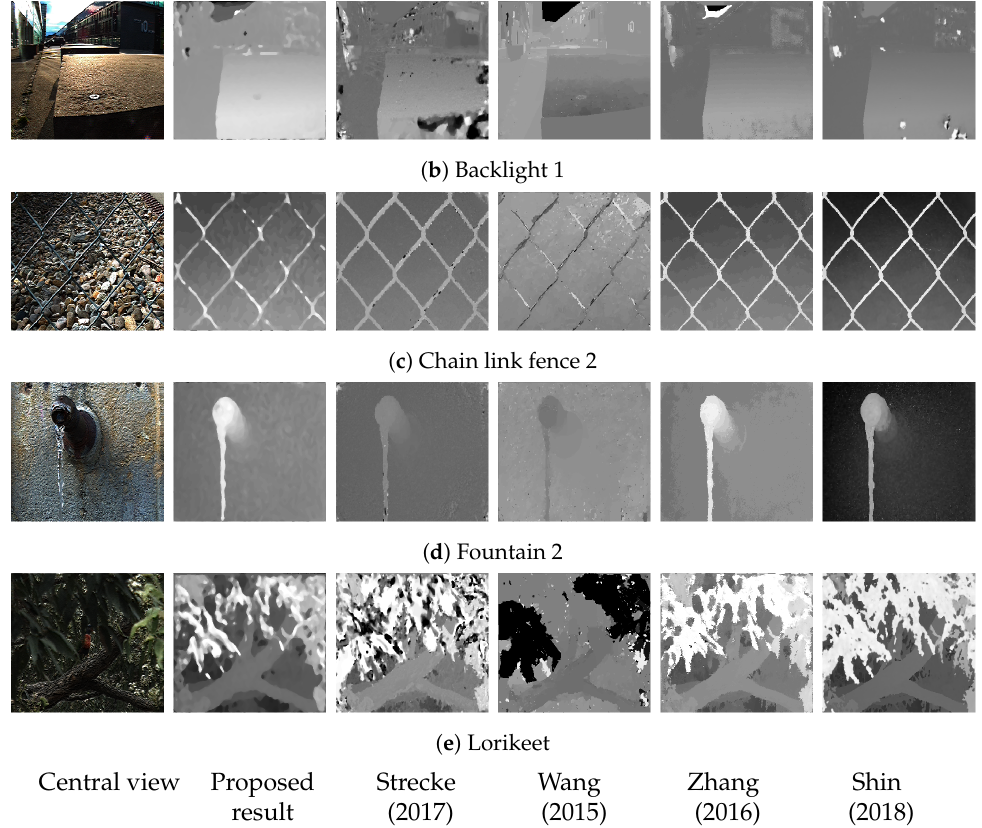
Figure 21. Visual comparison of the proposed algorithm with Strecke et al. [9], Wang et al. [10], Zhang et al. [11] and Shin et al. [12] for real LF images.